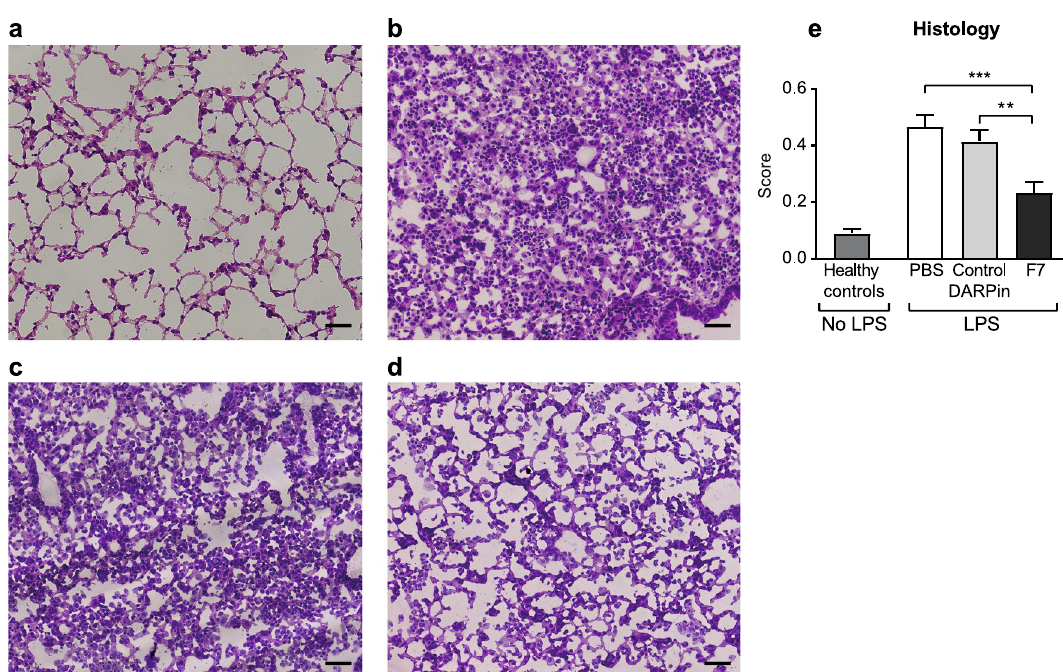
Figure 5. Histological analysis of lung sections shows reduction of inflammation during the acute phase. Representative histological sections of mice in the different treatment groups stained with hematoxylin–eosin: ( a ) Healthy controls, ( b ) PBS, ( c ) control DARPin, ( d ) F7. The scale bar indicates 50 µm. ( e ) The lung injury scoring system according to Matute Bello et al. was used for histological analysis and is described in the “Methods” section. The histological score of the group treated with F7 was significantly lower compared to the PBS or control DARPin treated group indicating reduced histological signs of inflammation. Data are presented as mean ± SEM. n = 5–19, ** p < 0.01, *** p < 0.001. Treatment groups were compared by an unpaired t-test. The scale bar represents 50